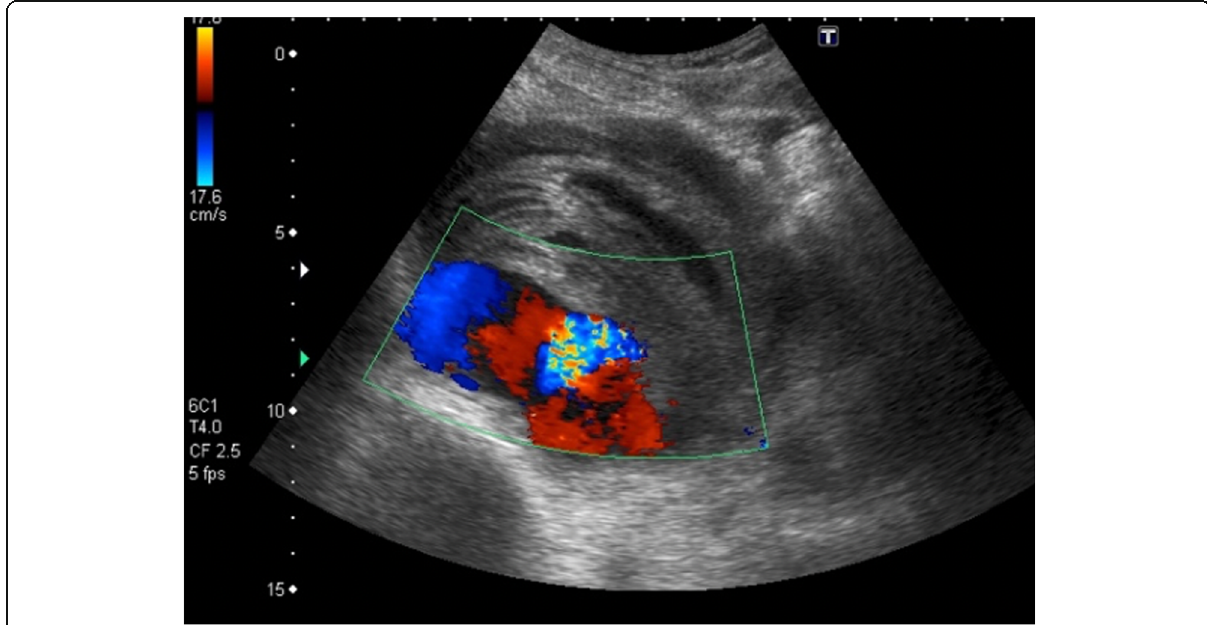
Fig. 2 Doppler ultrasound of the right external iliac artery showing a 10.6 × 9.4 cm pseudoaneurysm with turbulent flow to the posterior iliopsoas region, compatible with